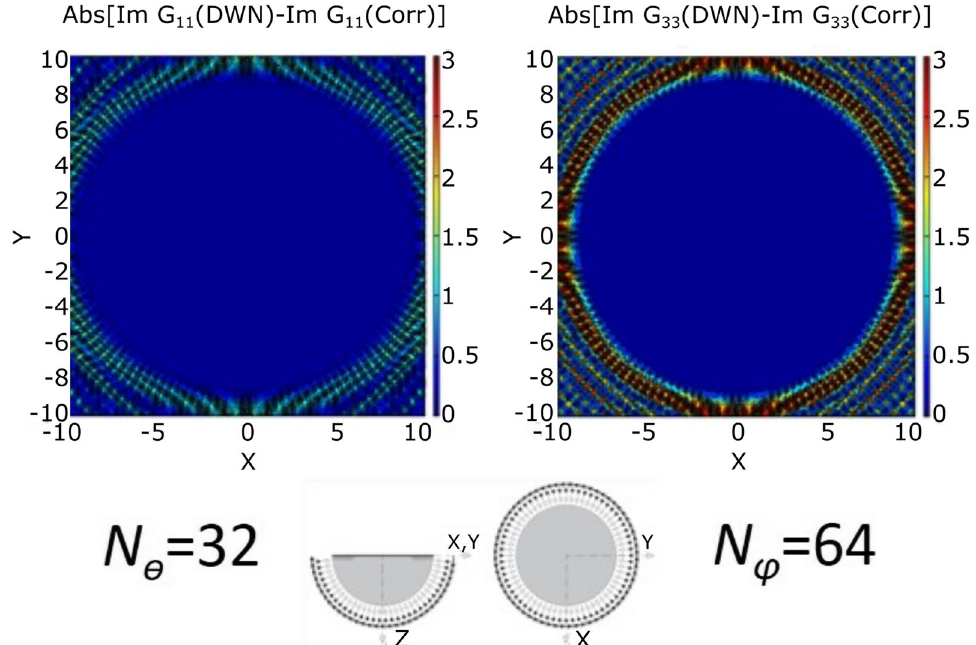
Fig. 5 Relative errors of surface results within a square for a horizontal and vertical unit harmonic forces, respectively. Illumination is given by N 32 and N φ 64. The square side has 20 ө = =